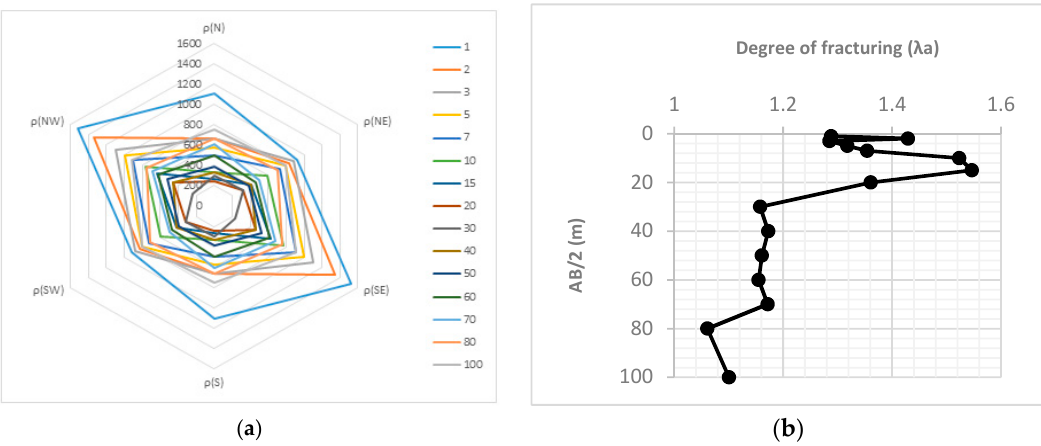
Figure 9. ( a ) Electrical anisotropy polygon constructed from plots of apparent resistivity along three azimuths. The fracture orientation trend principally in the NE–SW direction; ( b ) Plot of variation of degree with fracturing. This shows that there is diminution of fracture with depth.